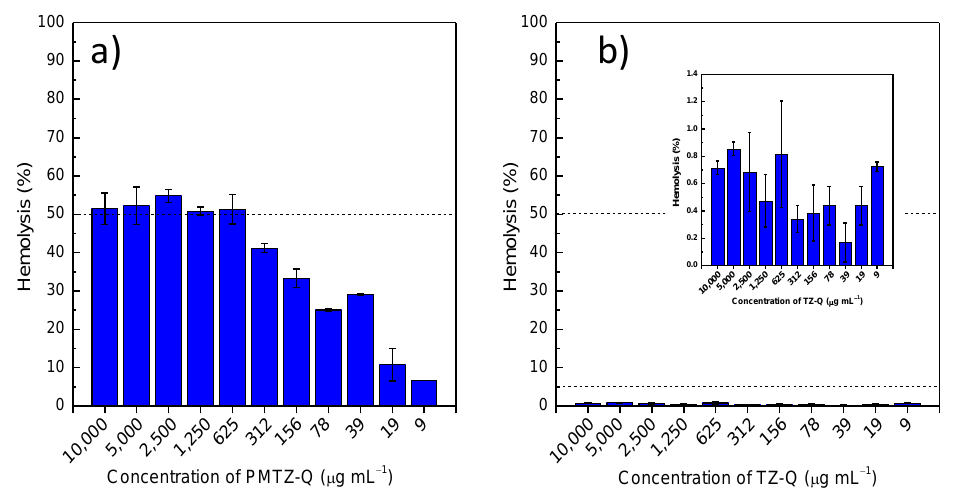
Figure 4. Hemolysis assays for ( a ) the cationic antibacterial polymer PMTZ-Bu and ( b ) for its degradation product TZ-Bu (inset, a magnification of the graph).